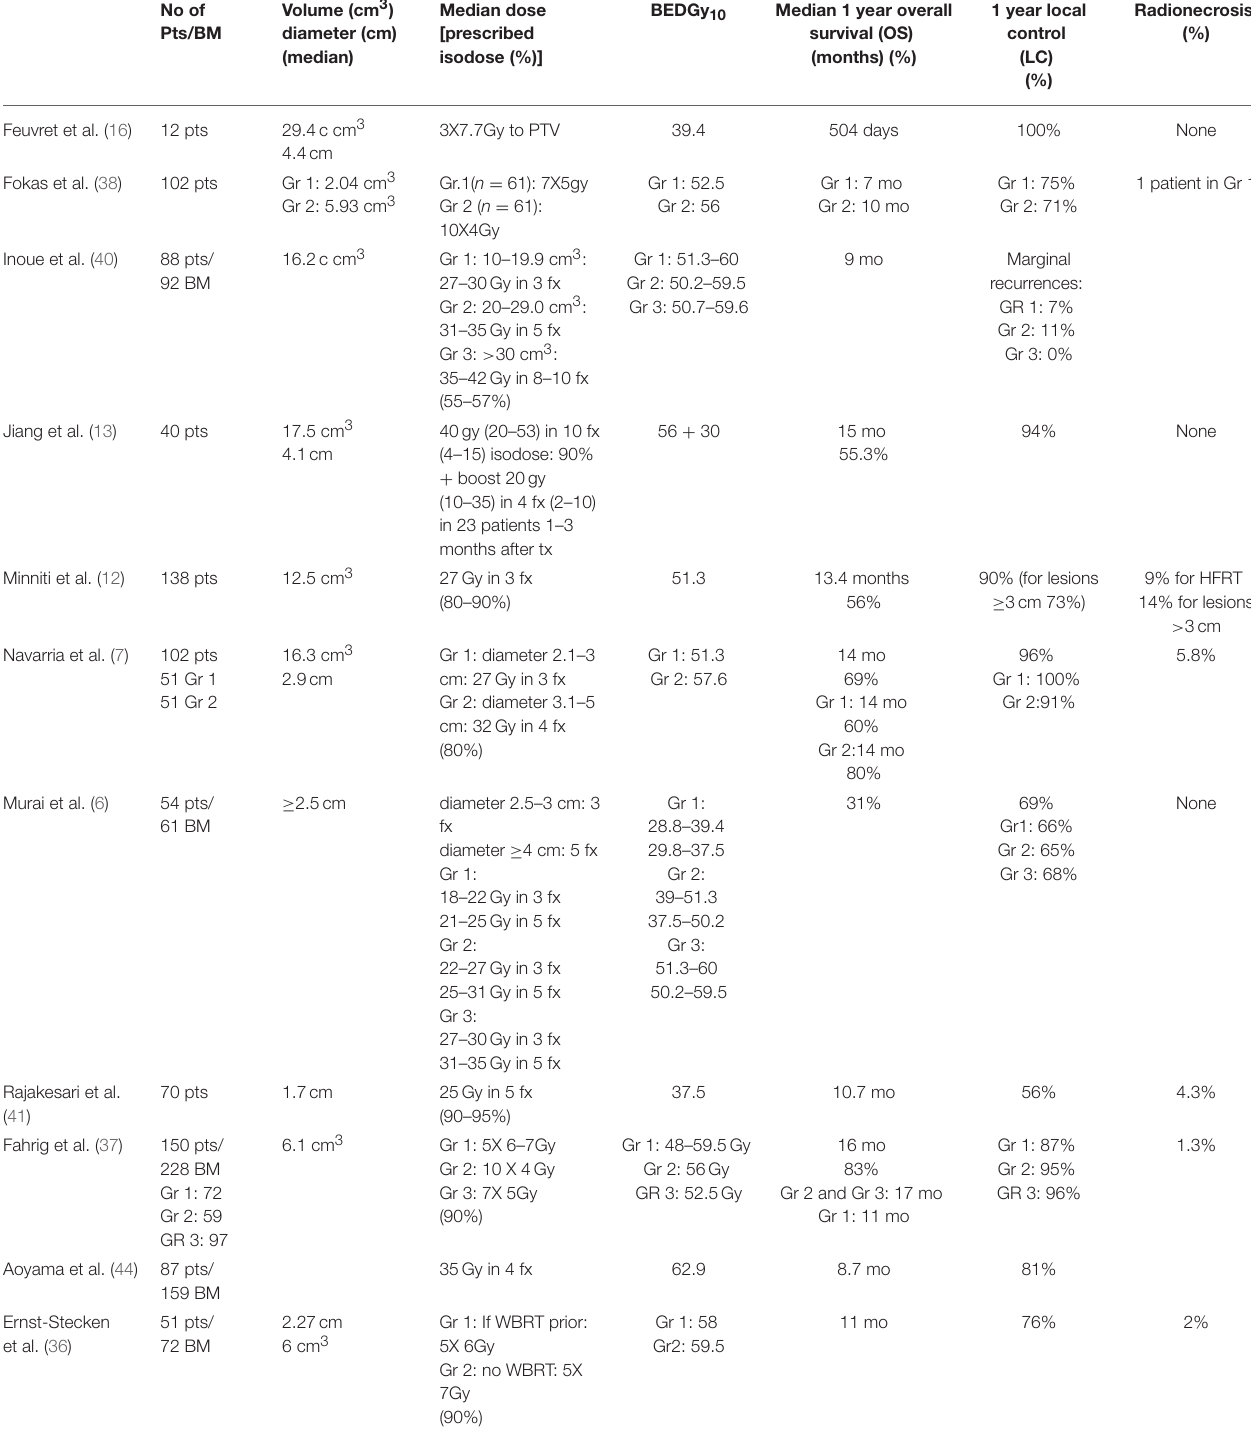
TABLE 1 | Selected series of patients treated with